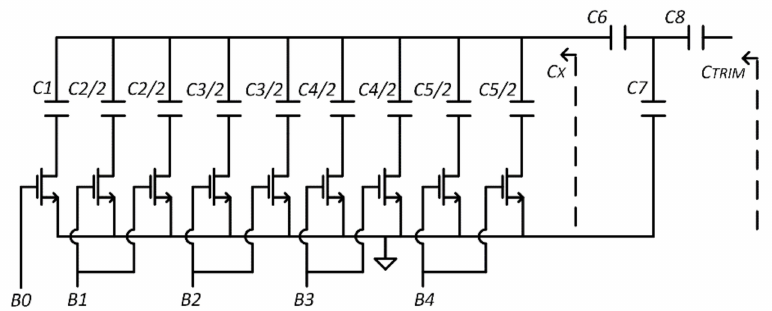
Figure 8. Capacitive trimming circuit